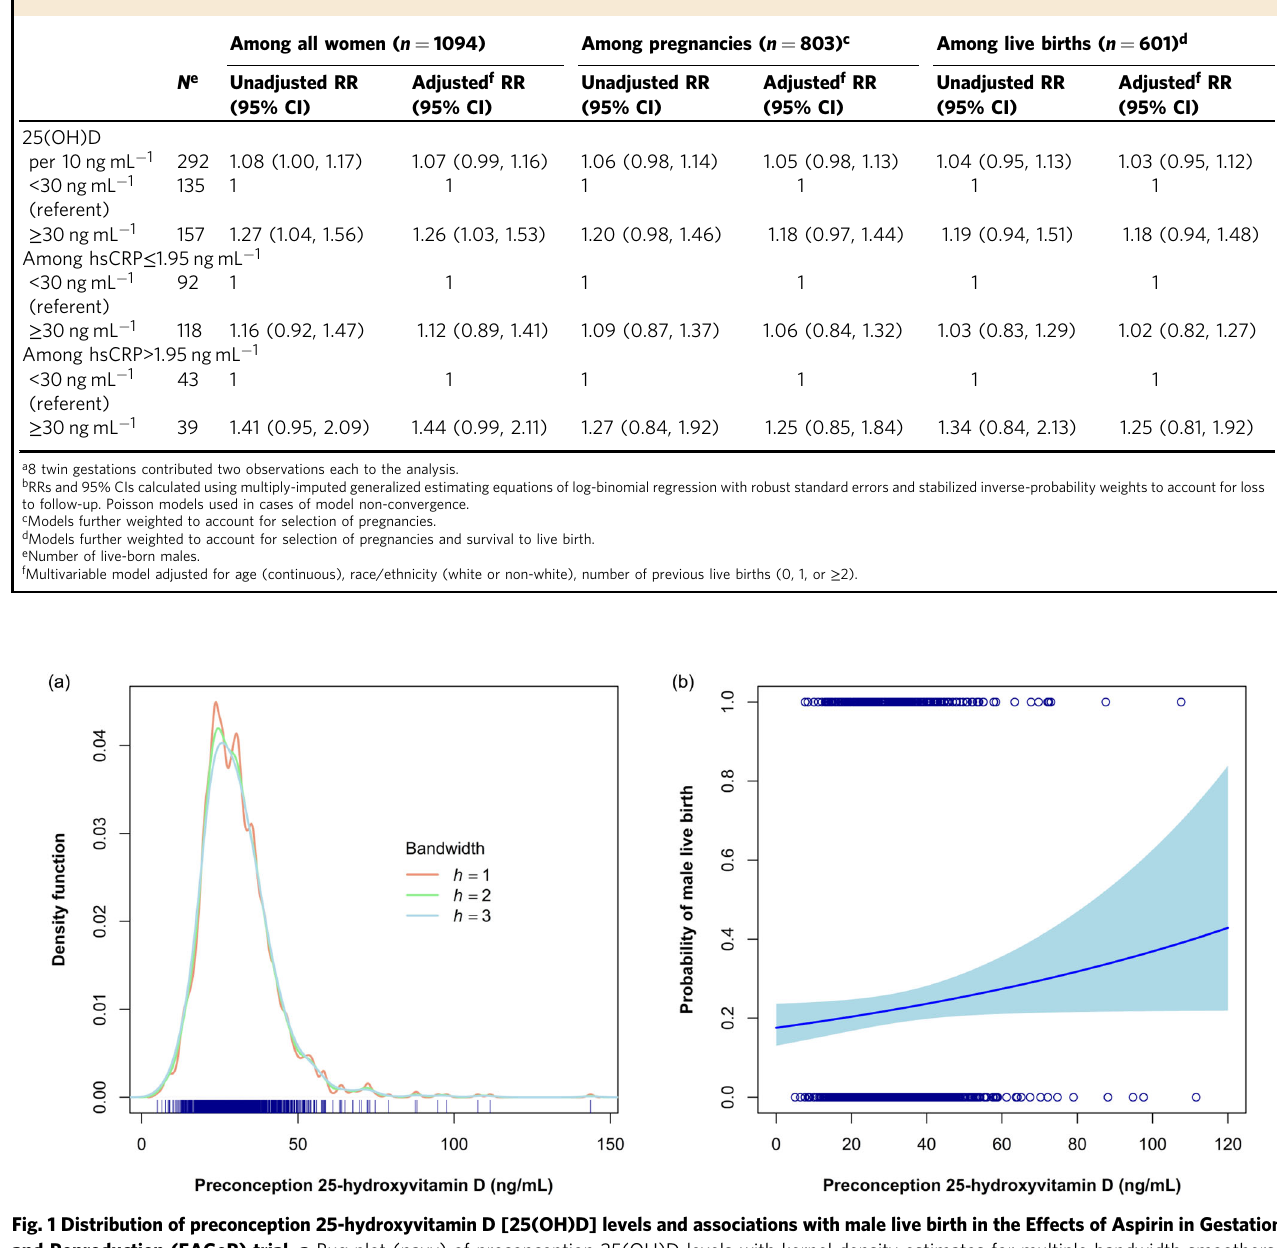
Table 2 Unadjusted and adjusted relative risks (RRs) and 95% con fi dence intervals (CIs) for 25-hydroxyvitamin D [25(OH)D] and male live birth Effects of Aspirin in Gestation and Reproduction (EAGeR) trial, 2007 – 2011 a,b